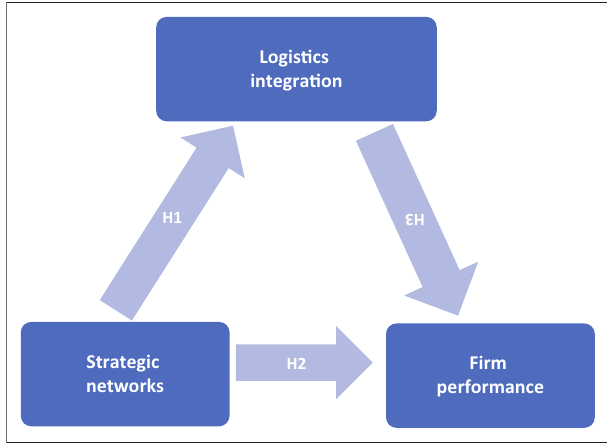
FIGURE 1: Conceptual